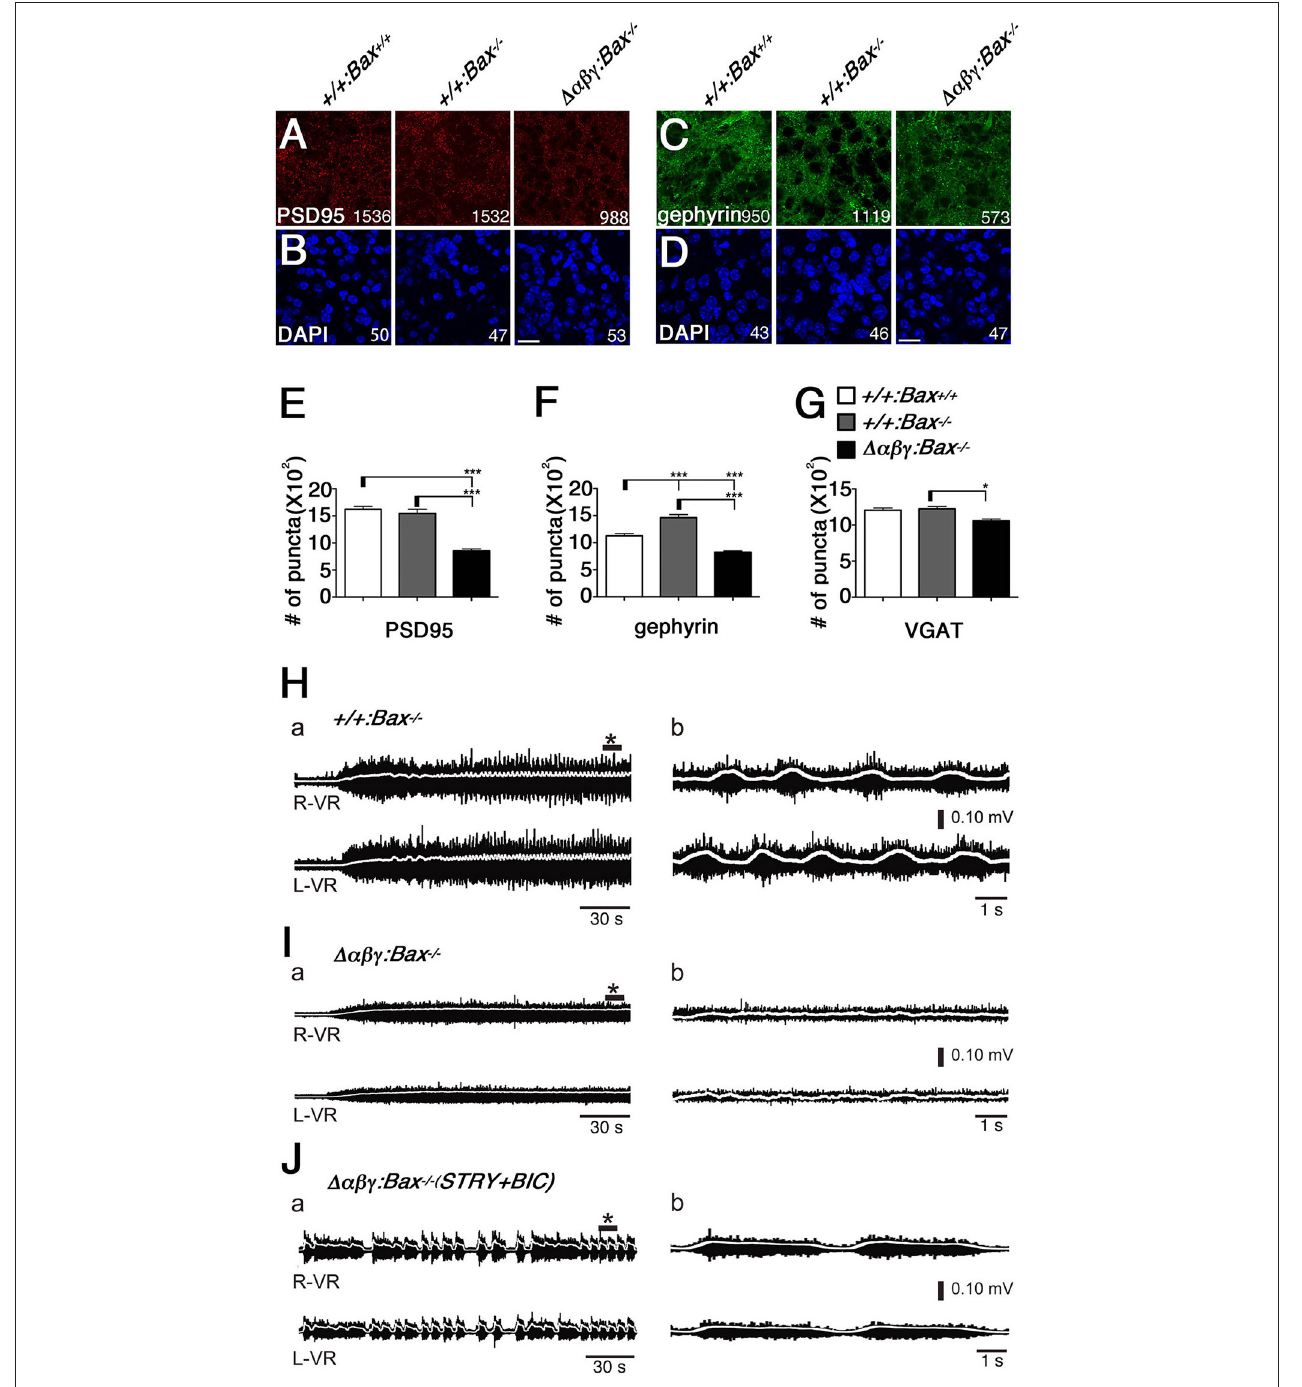
FIGURE 2 | The ∆αβγ :Bax − / − double mutants showed low synaptic density and no left-right alternation of locomotor-like activity. (A–D) The densities of the PSD95 + excitatory and gephyrin + inhibitory synapses were reduced in the ∆αβγ ;Bax − / − double mutants. The number of synaptic puncta or cells per microscope field is shown. (E–G) The numbers of PSD95 + , gephyrin + , and VGAT + synaptic puncta were significantly decreased in the double mutants. N = 33, 23, 68 microscope fields for PSD95 + and 32, 50, 77 for gephyrin + . Error bars represent SEM. , *** P < 0.001, * P < 0.05 by one-way ANOVA and post-hoc Tukey tests. Bars: 20 µ m. (H) Normal left-right alternating locomotor-like motor activity was recorded after NMDA and 5-HT were applied to isolated E18.5 control spinal cords, and VR activity was recorded at the right (R-VR) and left (L-VR) sides of the second (L2) lumbar segment. (I) The double-mutant mice did not exhibit the left-right alternation. (J) Left-right synchronous rhythm was evoked in the ∆αβγ :Bax − / − double-mutant spinal cord when the inhibitory synaptic transmission was blocked by bath application of the glycinergic antagonist strychnine (STRY) and the GABAergic antagonist bicuculline (BIC). Panels in (b) show magnified views of * shown in (a). In this figure, TG taf 7 was included in each of